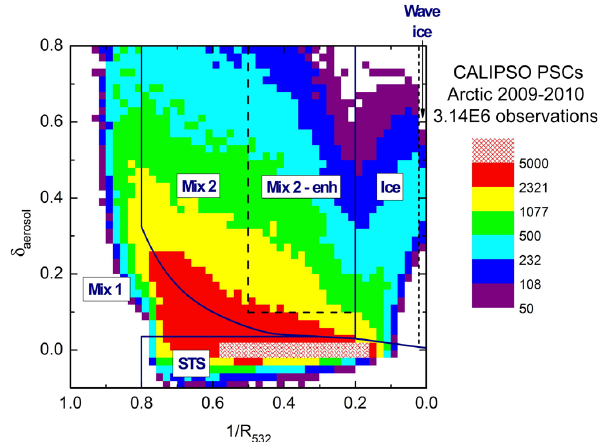
Fig. 1. Composite 2-D histogram of all CALIOP PSC observations during the 2009–2010 Arctic winter in the δ aerosol vs. 1 /R 532 co- ordinate system, with the solid black lines denoting the boundaries of the six PSC composition domains defined by P09 and the dashed boxes denoting the domains of the two new composition sub-classes defined by P11. The histogram bin size is 0 . 02 × 0 . 02 (both unit- less) and the color scale indicates the number of cloud observations falling within each